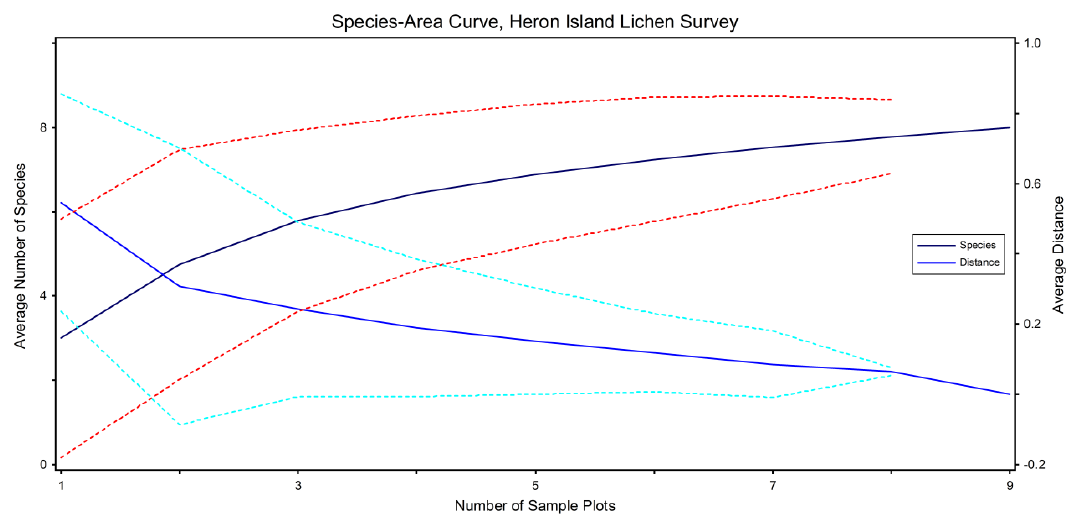
Figure S1. The lichen Lecanora arthothelinella on Argusia argentea bark.